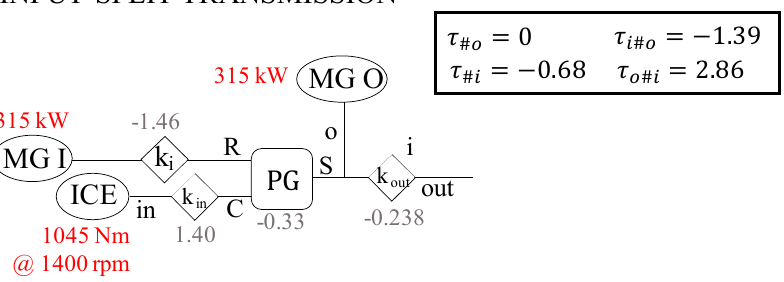
Figure 11. Functional layout of the input-split transmission designed for ICE working at 1400 rpm and 1045 Nm.